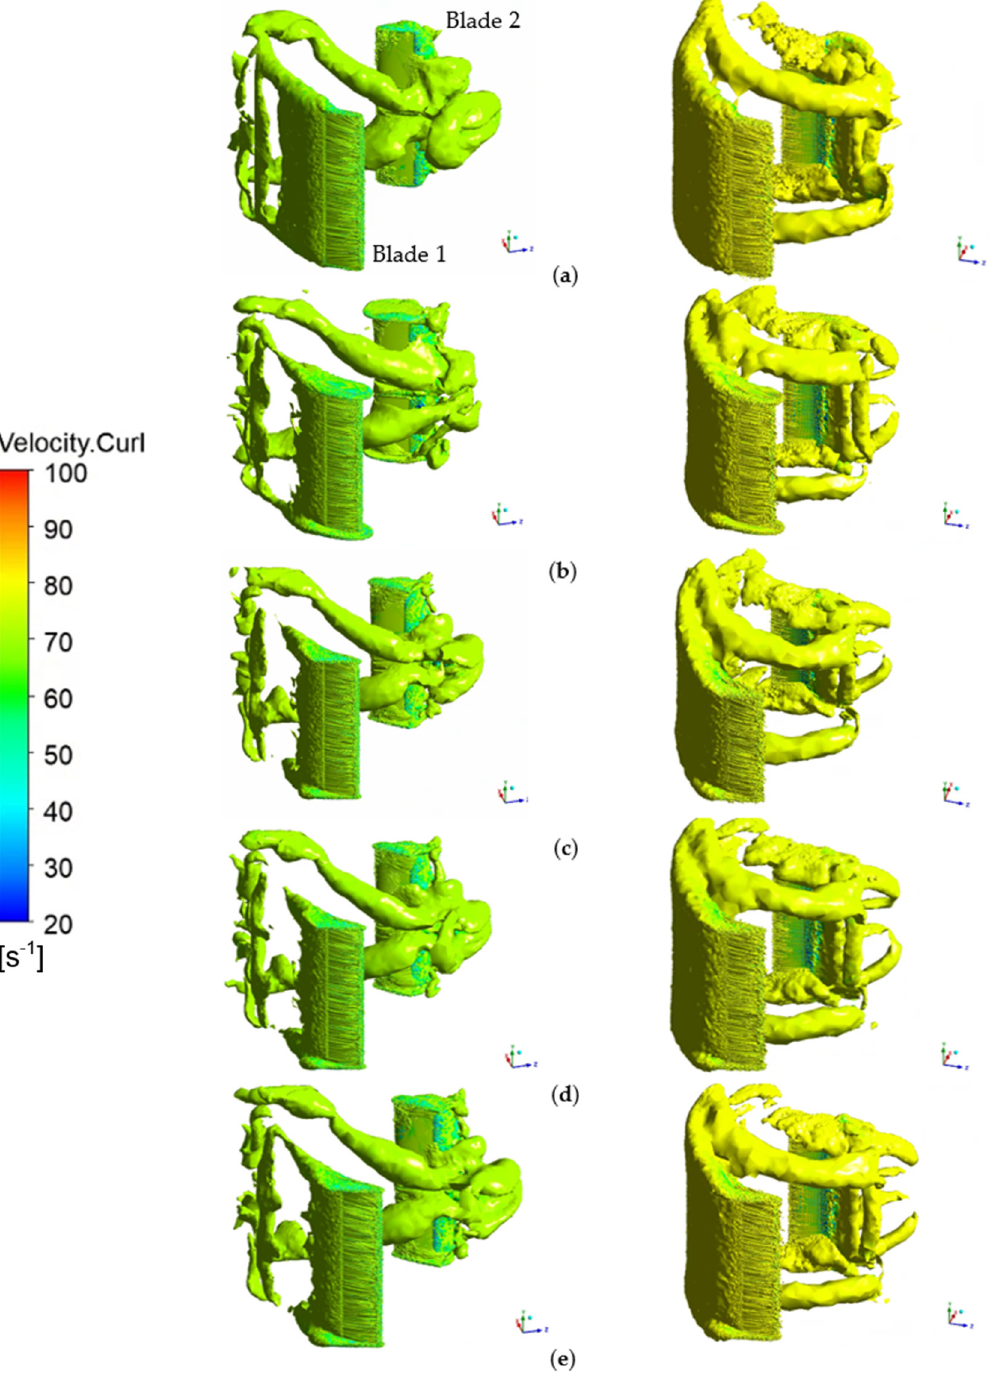
Figure 8. Vorticity of ( a ) baseline, ( b ) offset, ( c ) symmetric V, ( d ) asymmetric, and ( e ) triangular endplates at θ = 60° in TSR 1 (left column) and θ = 90° in TSR 2 (right column).